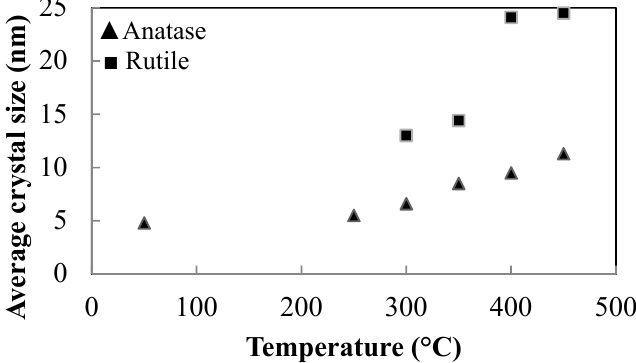
Figure 7. Average crystallite size of sample A listed in Table 1 at increasing temperature of calcination.